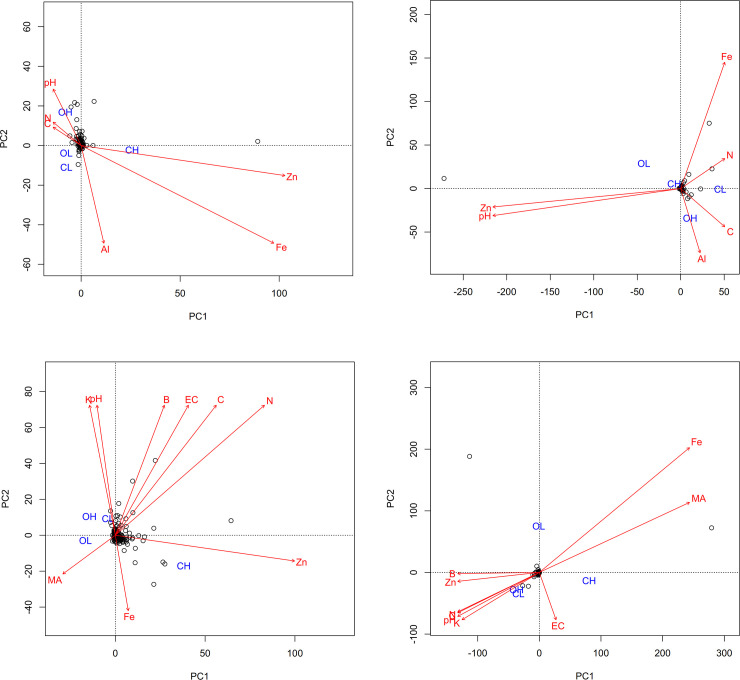
a-d. Principal component analysis of soil physicochemical characteristics that drive diversity within farming systems. OH, CH, OL and CL represents Org-High, Conv-High, Org-Low and Conv-Low farming systems.